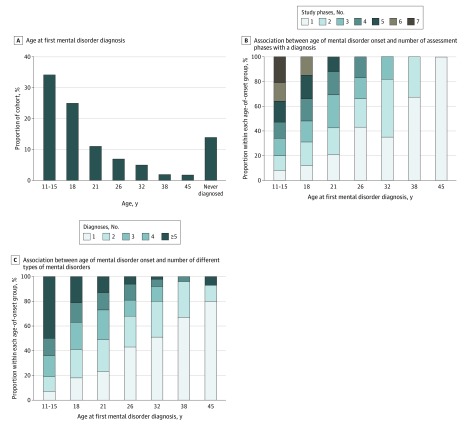
Early-Onset Mental Disorders and Their SequelaeA, Assessment age at which participants first met diagnostic criteria for a mental disorder. B, Proportion of participants within each onset age who met diagnostic criteria for a mental disorder in 1, 2, 3, 4, 5, 6, or 7 assessment windows. C, Proportion of participants within each onset age who met diagnostic criteria for 1, 2, 3, 4, or 5 or more different types of mental disorders in subsequent years, up to midlife.